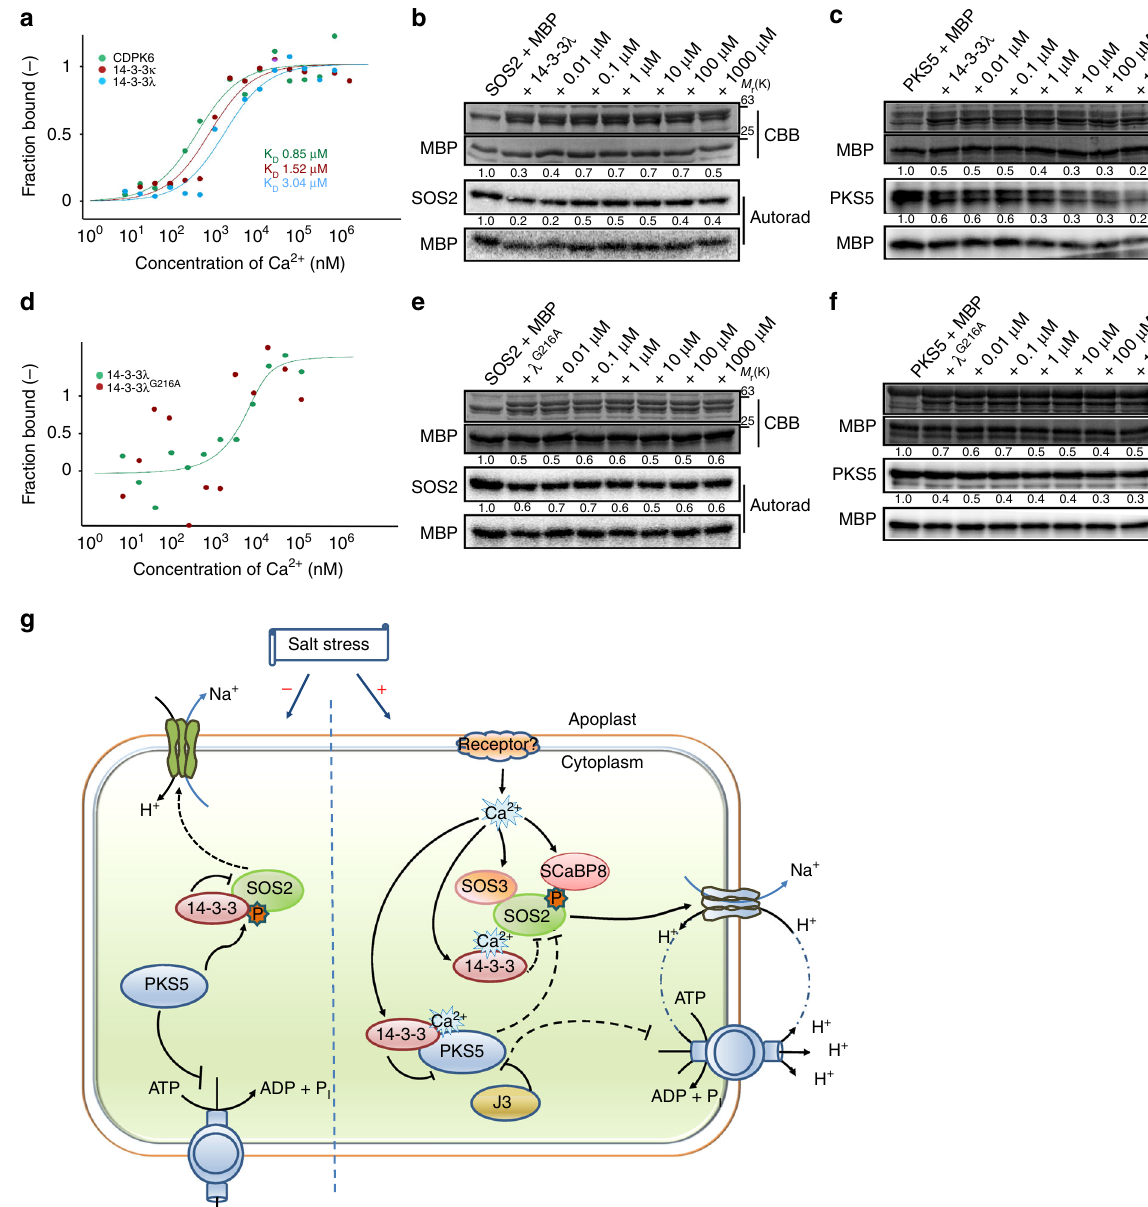
Fig. 7 14-3-3-mediated regulation of SOS2/PKS5 kinase activity by calcium ions. a MST assay showing that 14-3-3 λ and κ interact with calcium ions. CDPK6 served as a positive control. Data are representative of three independent biological experiments. b In vitro kinase assay showing that Ca 2 + decreases the 14-3-3-mediated repression of SOS2. c In vitro kinase assay showing that Ca 2 + enhances the 14-3-3-mediated repression of PKS5. d MST assay of the Ca 2 + -binding af fi nity of 14-3-3 λ G216A . Data are representative of three independent biological experiments. e In vitro kinase assay showing that the 14-3-3 λ G216A mutant does not signi fi cantly repress SOS2 activity in the presence of Ca 2 + . f In vitro kinase assay showing that the 14-3-3 λ G216A mutant does not signi fi cantly repress PKS5 activity in the presence of Ca 2 + . g Model illustrating how 14-3-3 proteins decode a calcium signal to enhance the salt tolerance of plants. Under normal growth conditions, PKS5 phosphorylates SOS2 Ser294 and represses SOS2 activity. Upon salt stress, 14-3-3 proteins decode a salt-induced calcium signal, repress PKS5, and release SOS2 to activate PM H + -ATPase and SOS1, respectively. For b and c , about 1.0 µ g of 14-3-3 λ protein was incubated with or without CaCl 2 at a fi nal concentration of 500 µ M and 5 mM EGTA at room temperature for 30 min before the kinase assay. MBP was used as a substrate. CBB Coomassie brilliant blue, Autorad autoradiograph. Source data of a – f are provided in the Source Data fi